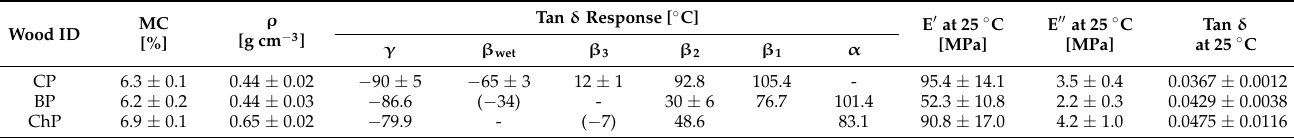
Table 2. Mean values of MC for pine samples at the start of the DMA measurement, bulk density of wood samples ( ρ ), temperature of tan δ responses, and E (cid:48) , E (cid:48)(cid:48) and tan δ measured at 25 ◦ C and a frequency of 1 Hz; contemporary pine samples: sound (CP), biologically degraded (BP) and chemically degraded (ChP); ± standard deviation; the value given in brackets refer to tiny, hardly distinguishable